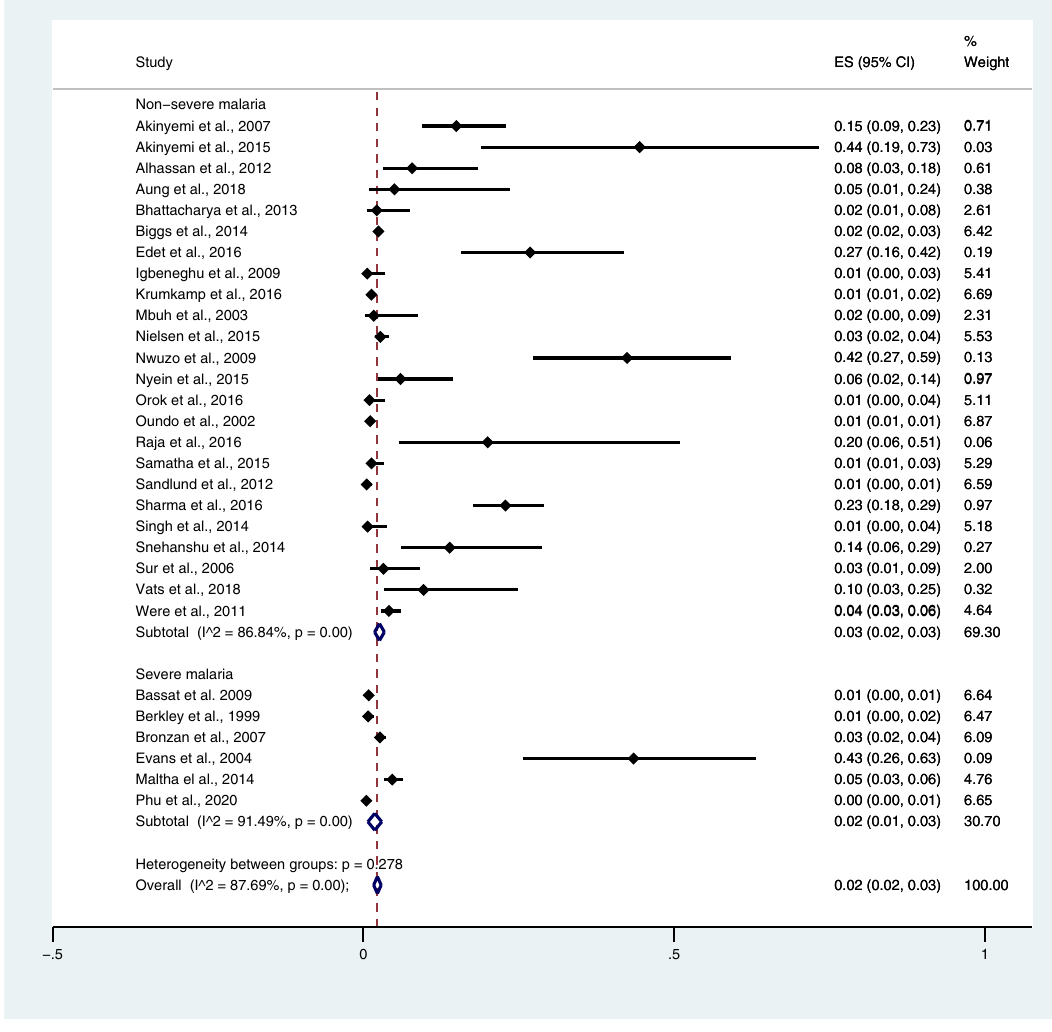
Figure 21. Pooled prevalence of typhoidal/NTS infection among patients with severe and non-severe malaria. ES proportion estimate (multiply 100 units for interpreted as prevalence estimate), CI confidence